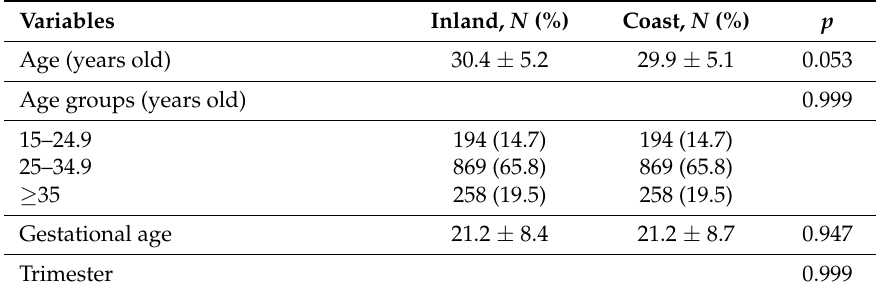
Table 1. Participants’ sociodemographic characteristics according to